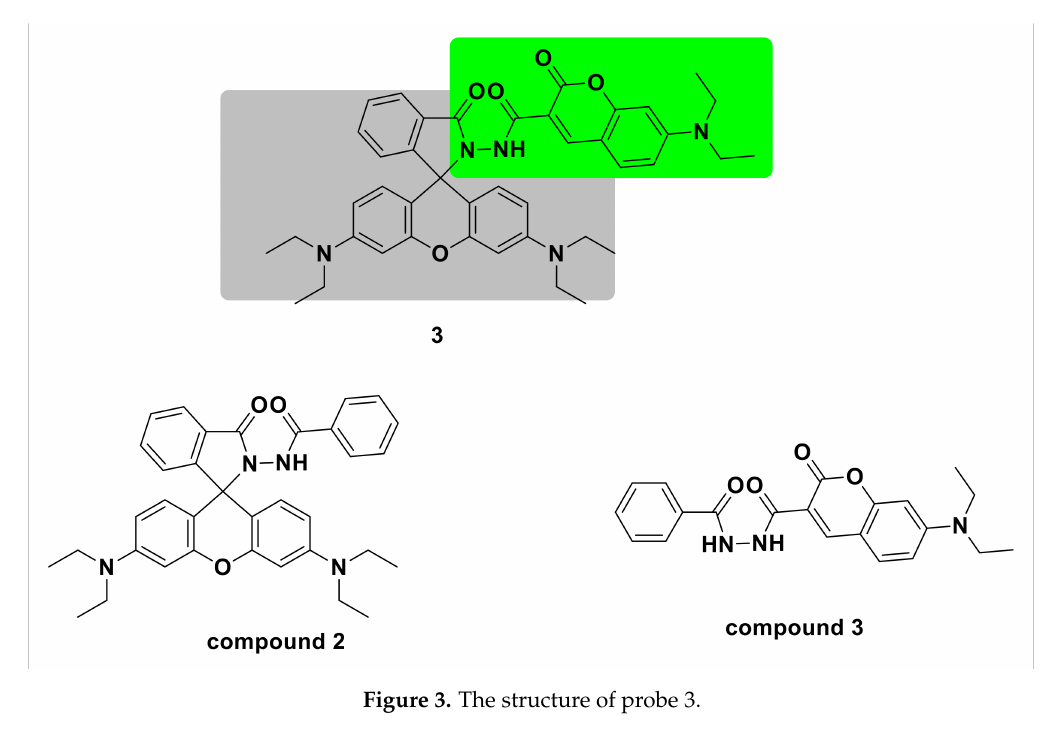
Figure 3. The structure of probe 3.